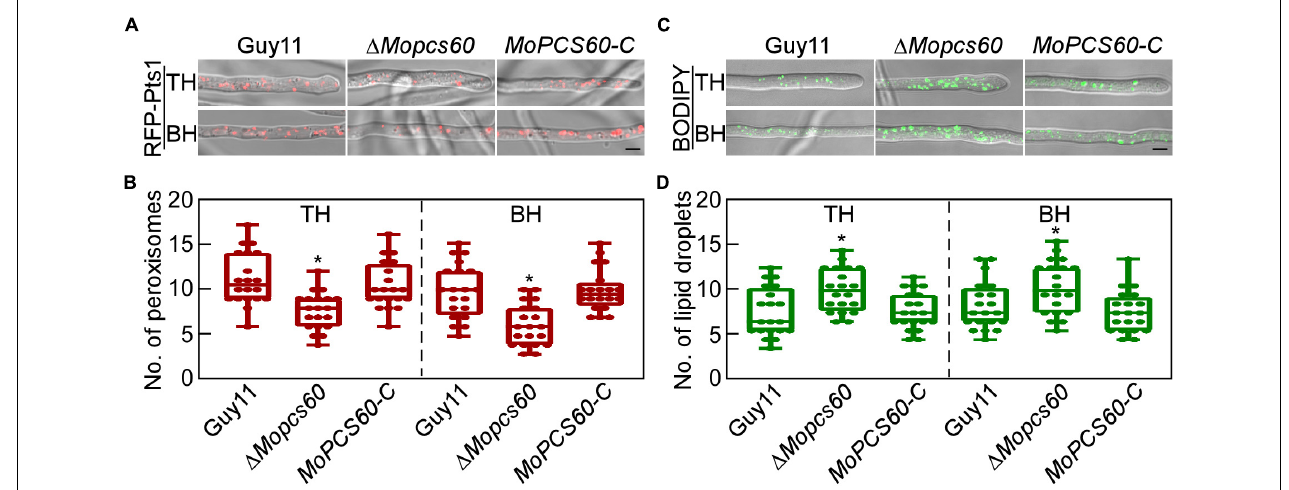
FIGURE 5 | The (cid:49) MoPcs60 mutant shows a decreased number of peroxisomes and an increased number of lipid droplets. (A) Peroxisomes were examined in tip (TH) and basal (BH) hyphae of Guy11, (cid:49) Mopcs60, and MoPCS60-C strains expressing RFP-Pts1 protein. Differential interference contrast (DIC) and fluorescent images were taken under a confocal microscope. Bar = 5 µ m. (B) Statistically analyzed the number of peroxisomes in 1 × 10 3 µ m from 20 fields of view in each strain and represented by a box-dot-plot. Statistical analysis was performed using GraphPad Prism 8.0.1, and asterisks represent significant differences at * p < 0.01. (C) Lipid droplets were examined in TH and BH of Guy11, (cid:49) Mopcs60, and MoPCS60-C strains stained by BODIPY 493/503. Bar = 5 µ m. (D) Statistically analyzed the number of lipid droplets in 1 × 10 3 µ m from 20 fields of view in each strain and represented by a box-dot-plot. Statistical analysis was performed using GraphPad Prism 8.0.1, and asterisks represent significant differences at * p <